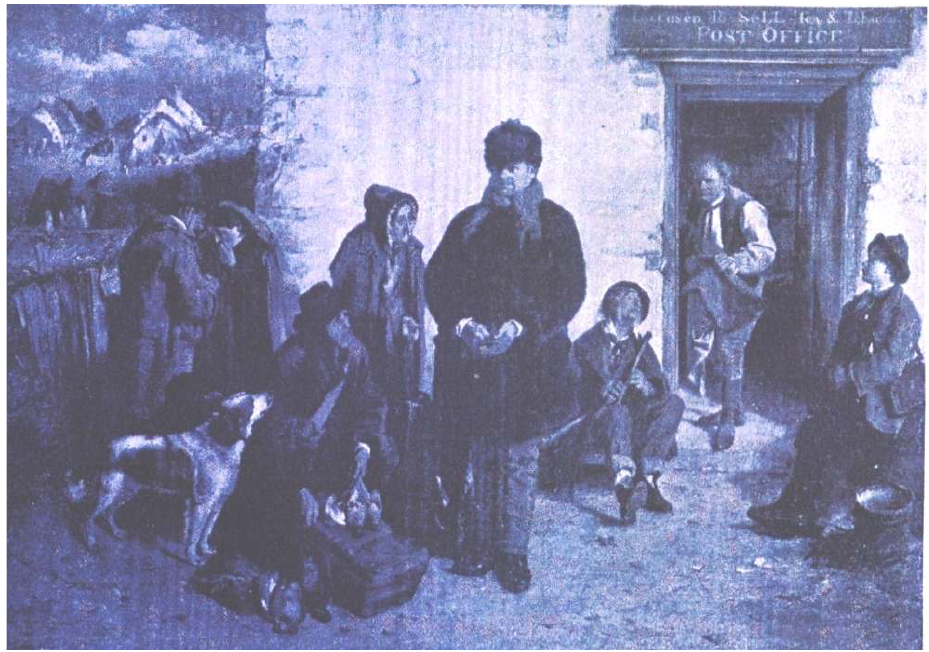
Figure : Erskine Nicol, Waiting at the Crossroads , oil painting, 71 x 105 cm,